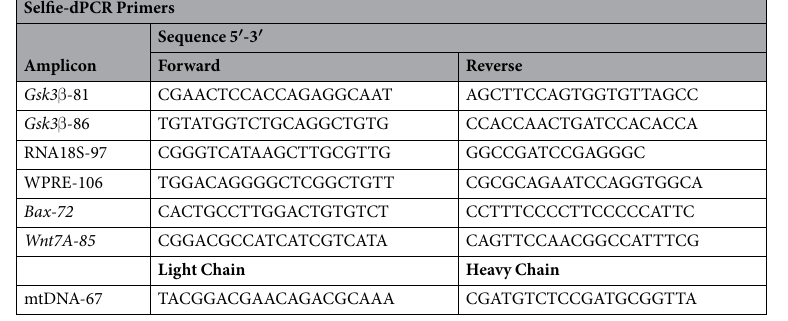
Table 1. Primer sequences used in the